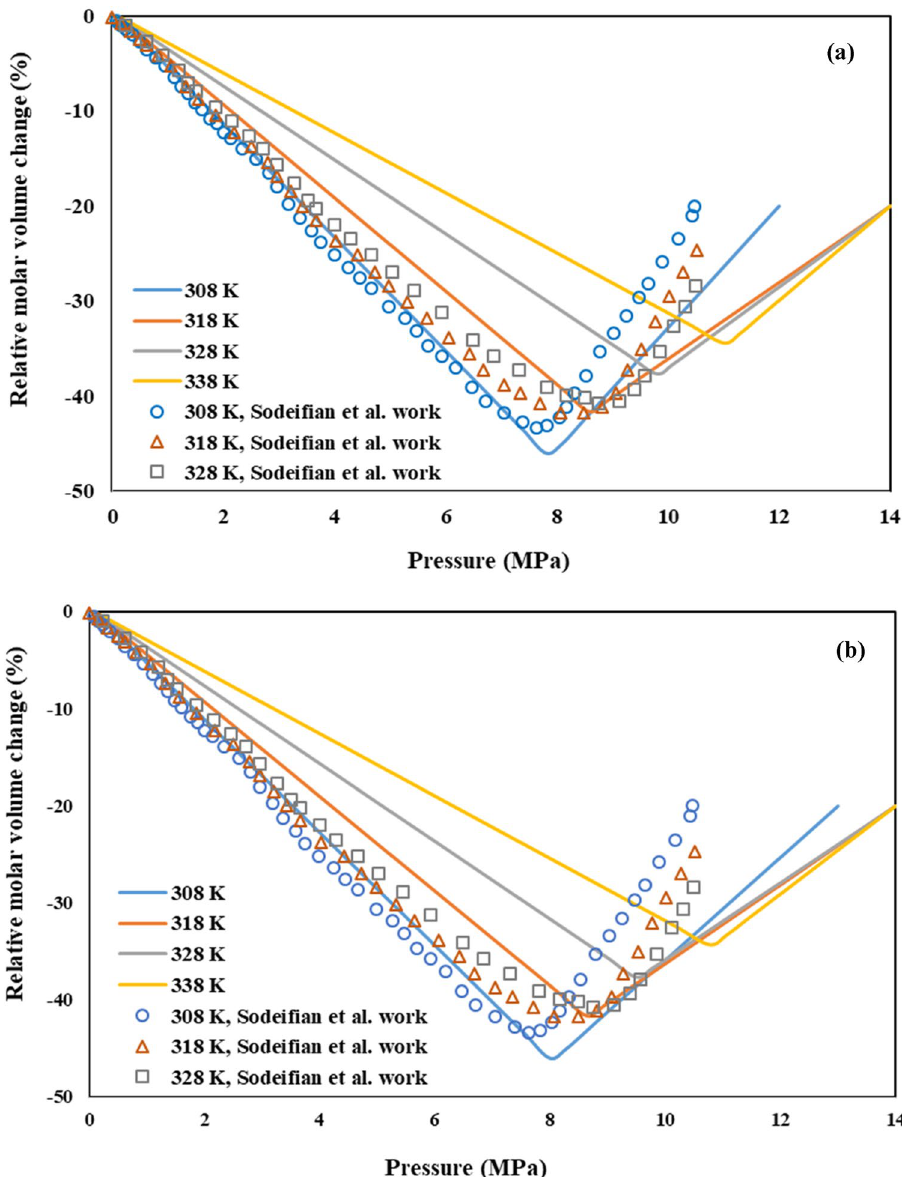
Figure 7. Relative molar volume change of the liquid phase vs. pressure, for the ternary systems (a) CO 2 – DMSO–AV3RN and (b) CO 2 –DMSO–SY33, at various temperatures (308, 318, 328 and 338